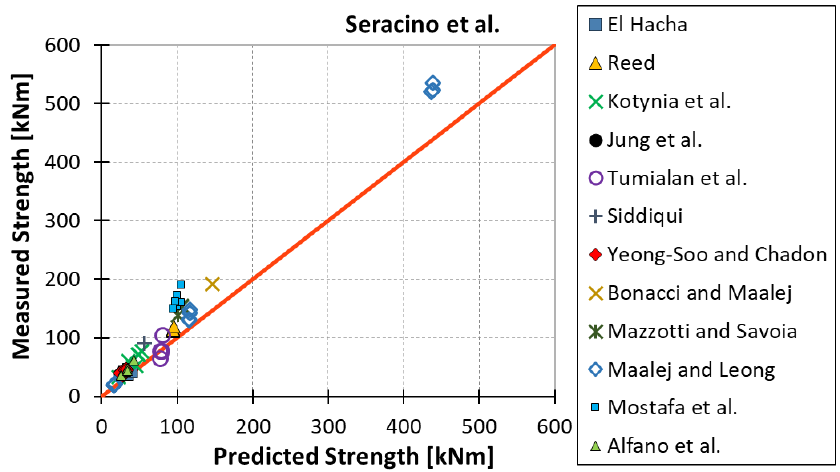
Figure 7. Measured flexural strength versus Seracino et al. model prediction.